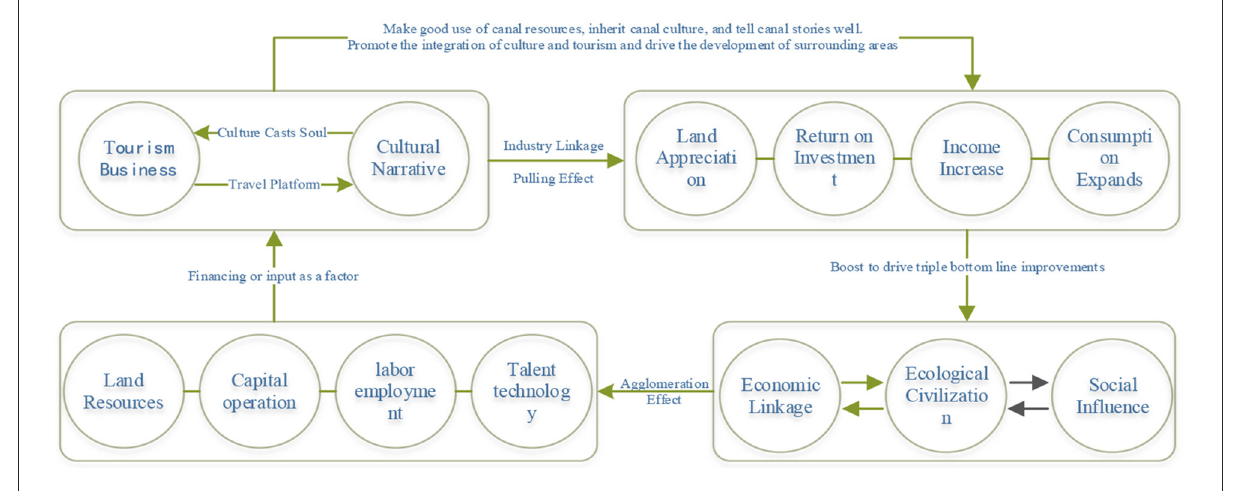
FIGURE4 Framework for the renewal and development of historic